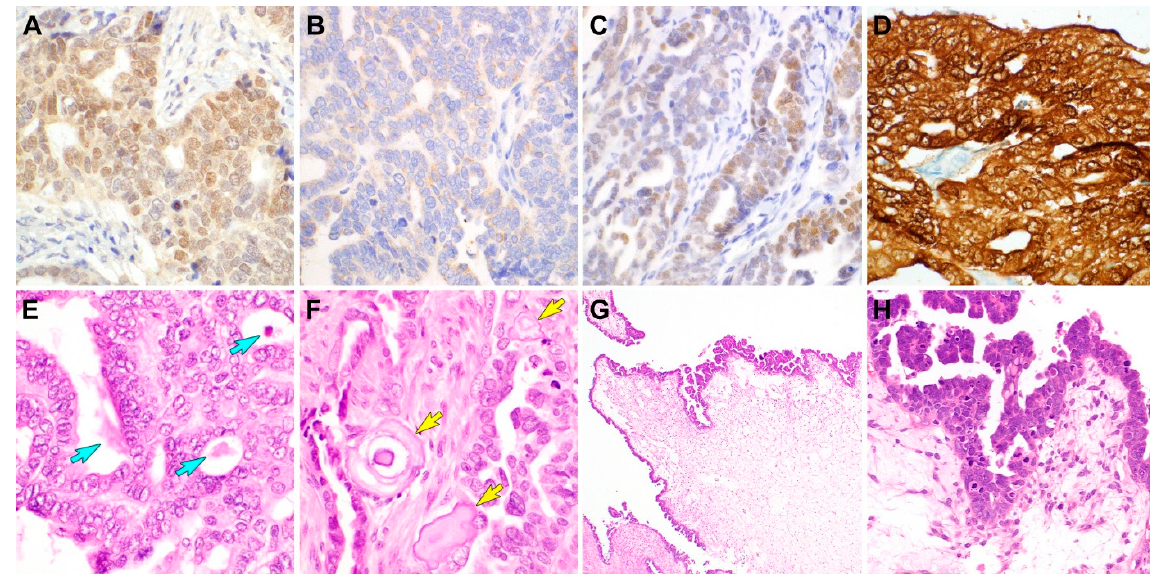
Figure 2. Immunostaining results ( A – D ) and histological features detected on re-examination ( E – H ). ( A ) Paired box 2 expression observed in most tumor cell nuclei, though the staining intensity was weak-to-moderate. ( B ) GATA-binding protein 3 expression was absent, which does not support uterine mesonephric-like adenocarcinoma (MLA). ( C ) p53 expression was patchy, with faint-to-weak staining intensity in approximately half of the tumor cell nuclei. This wild-type p53 immunostaining pattern is compatible with MLA but not with endometrial serous carcinoma (SC). ( D ) Uniform and intense nuclear and cytoplasmic p16 immunoreactivity in the entire tumor tissue strongly indicated the possibility of SC. These immunostaining results made us re-examine the hematoxylin and eosin-stained slides. ( E ) We found a few additional microscopic foci showing intraluminal eosinophilic secretions (blue arrows). ( F ) The presence of psammomatous microcalcifications (yellow arrows), which was not identified in initial microscopic examination, further supported SC. ( G ) Large papillae with edematous stroma possessing many variable-height micropapillae along their surface. ( H ) High-power magnification of the micropapillae revealing nuclear hyperchromasia and severe pleomorphism as well as numerous mitotic figures and many apoptotic bodies, all of which are compatible with SC. Staining method: ( A – D ) polymer method; ( E – H ) hematoxylin and eosin staining. Original magnification: ( A – F ) ×400; ( G ) ×40; ( H ) ×200.